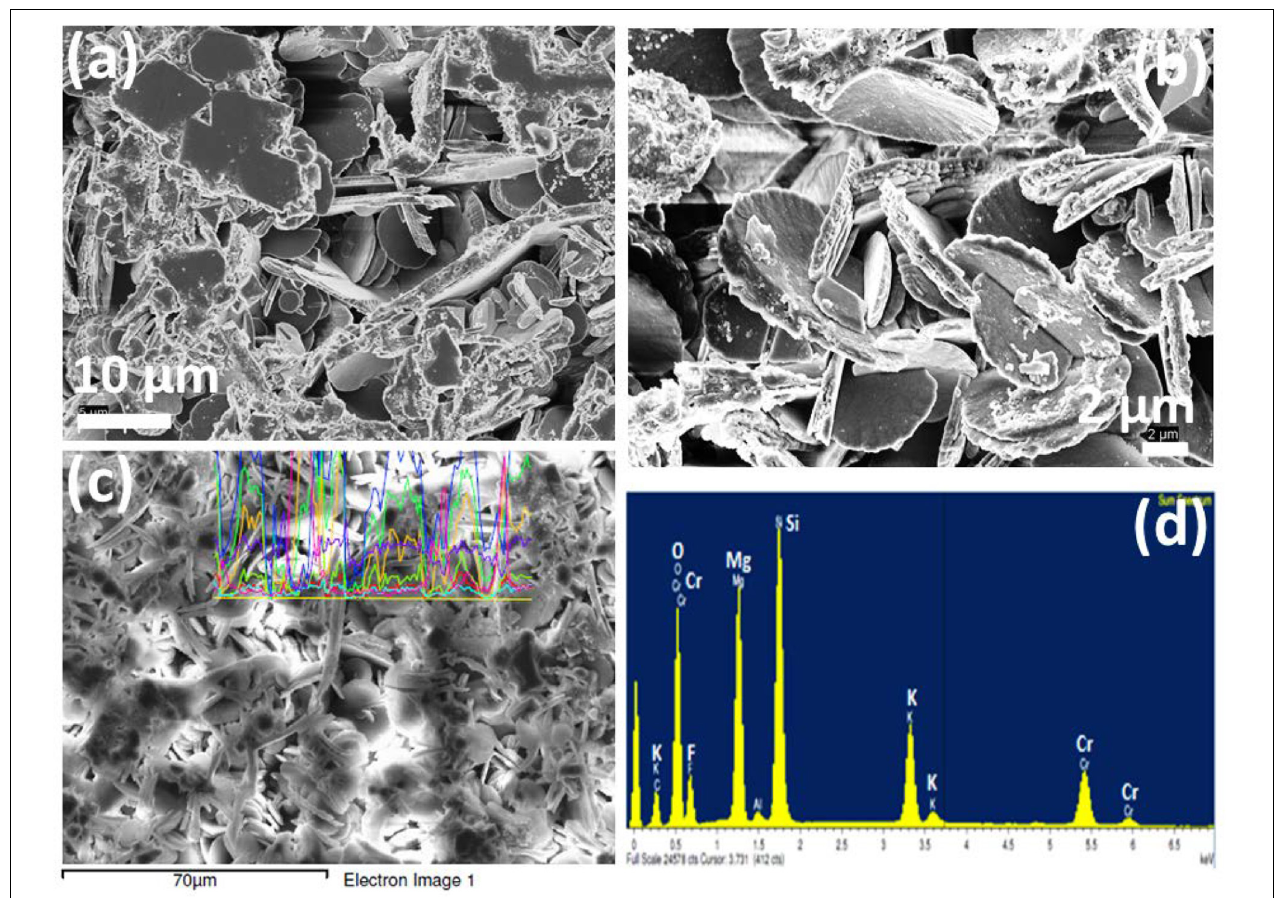
FIGURE 8 | (a,b) FESEM photomicrographs (in 10 and 2 µ m) and (c,d) EDX pattern of K 2 O-MgO-Al 2 O 3 -B 2 O 3 -SiO 2 -F glass containing 7mol% K 2 Cr 2 O 7 content, Cr-7; showing the dispersed crystalline phases (MgCr 2 O 4 , MgF 2 and K 3 CrF 6